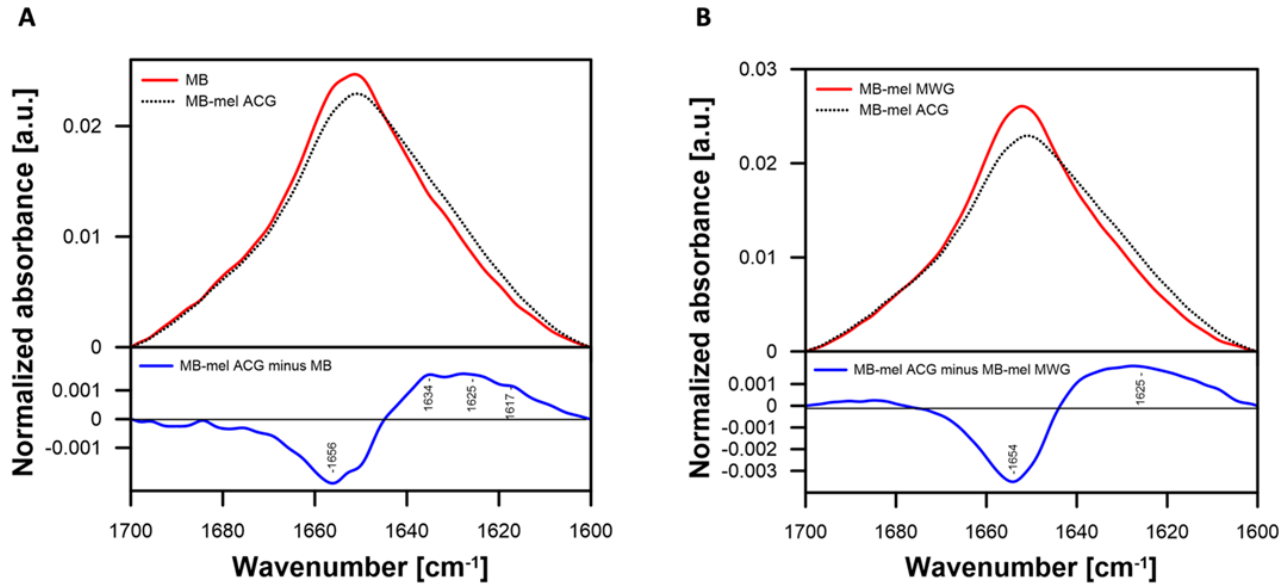
Figure 3. FTIR spectra were recorded in the amide I region. ( A ) A comparison of spectra recorded for Myoglobin (MB) and the glycated protein MB-mel ACG or ( B ) MB-mel MWG and MB-mel ACG is presented. The lower panels present the difference spectra calculated based on the spectra in the upper panels (as explained in the legends). The spectra in the upper panels are area-normalized.